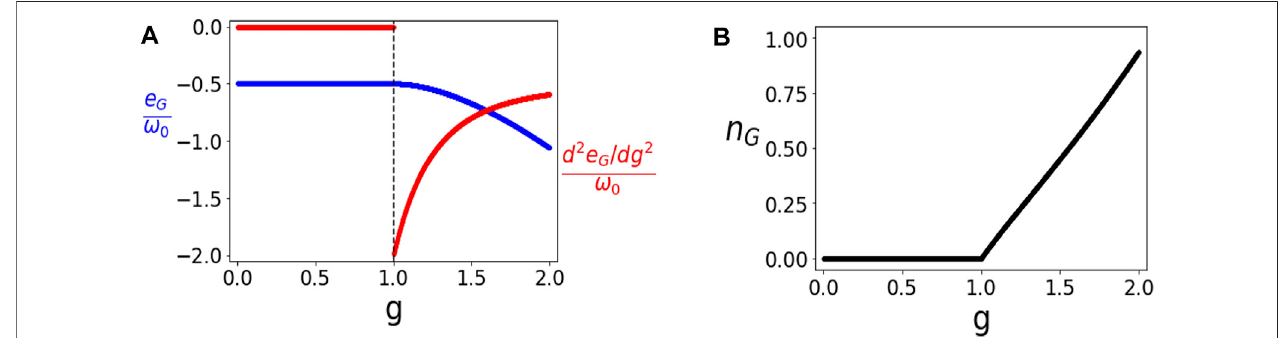
FIGURE 1 | Phase Transition in Quantum Rabi Model. (A) The rescaled ground state energy e G / ω 0 (cid:1) 〈 H Rabi 〉 / Ω and ( d 2 e G / dg 2 )/ ω 0 as functions of g . The discontinuity in ( d 2 e G / dg 2 )/ ω 0 at g = g c = 1 indicates a countinuous phase transition. (B) The order parameter n G (cid:1) ω 0 Ω 〈 a † a 〉 as a function of g . n G becomes non-zero when the Z 2 symmetry is spontaneously broken at g > g c =